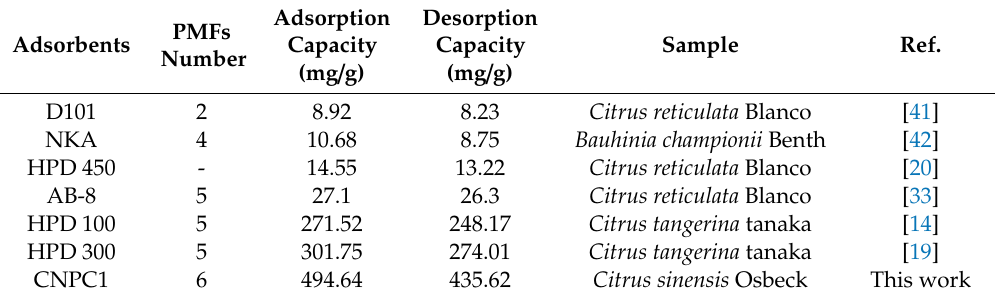
Table 2. Comparison of the proposed methods with other methods for enriching